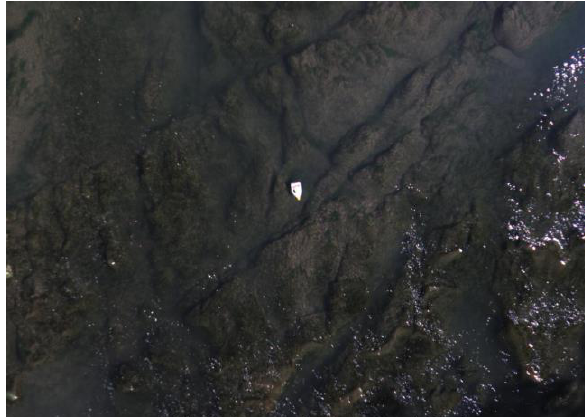
Figure 3. Image of the dataset represented in RGB. It is possible distinguish the plastic sample at the center of the image.